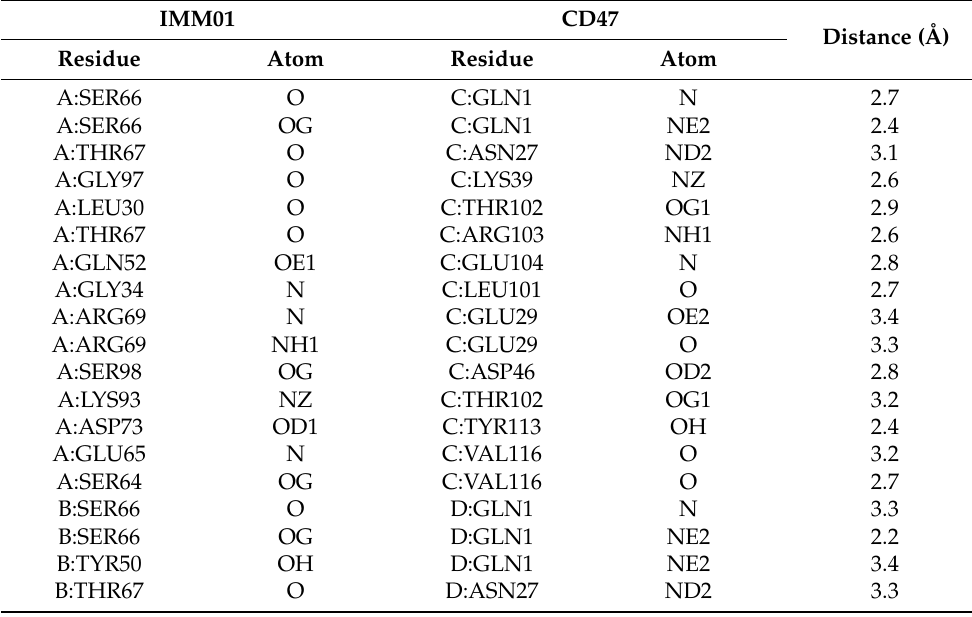
Table 1. Common hydrogen bonds between IMM01 and CD47. IMM01